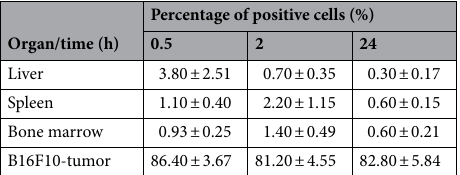
Table 1. Percentage of positive cells for in vivo exposed organs to probe Sgc8-c-Alexa647 analyzed by flow